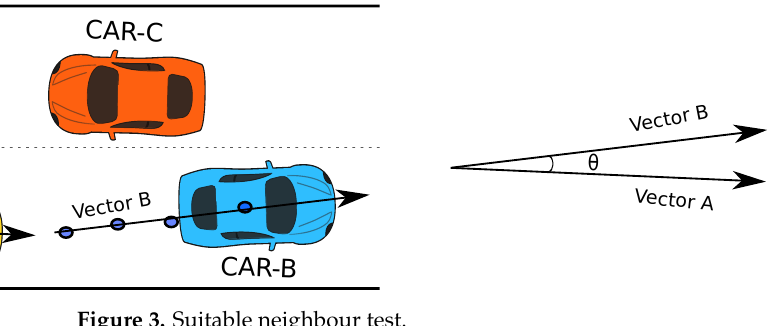
Figure 3. Suitable neighbour